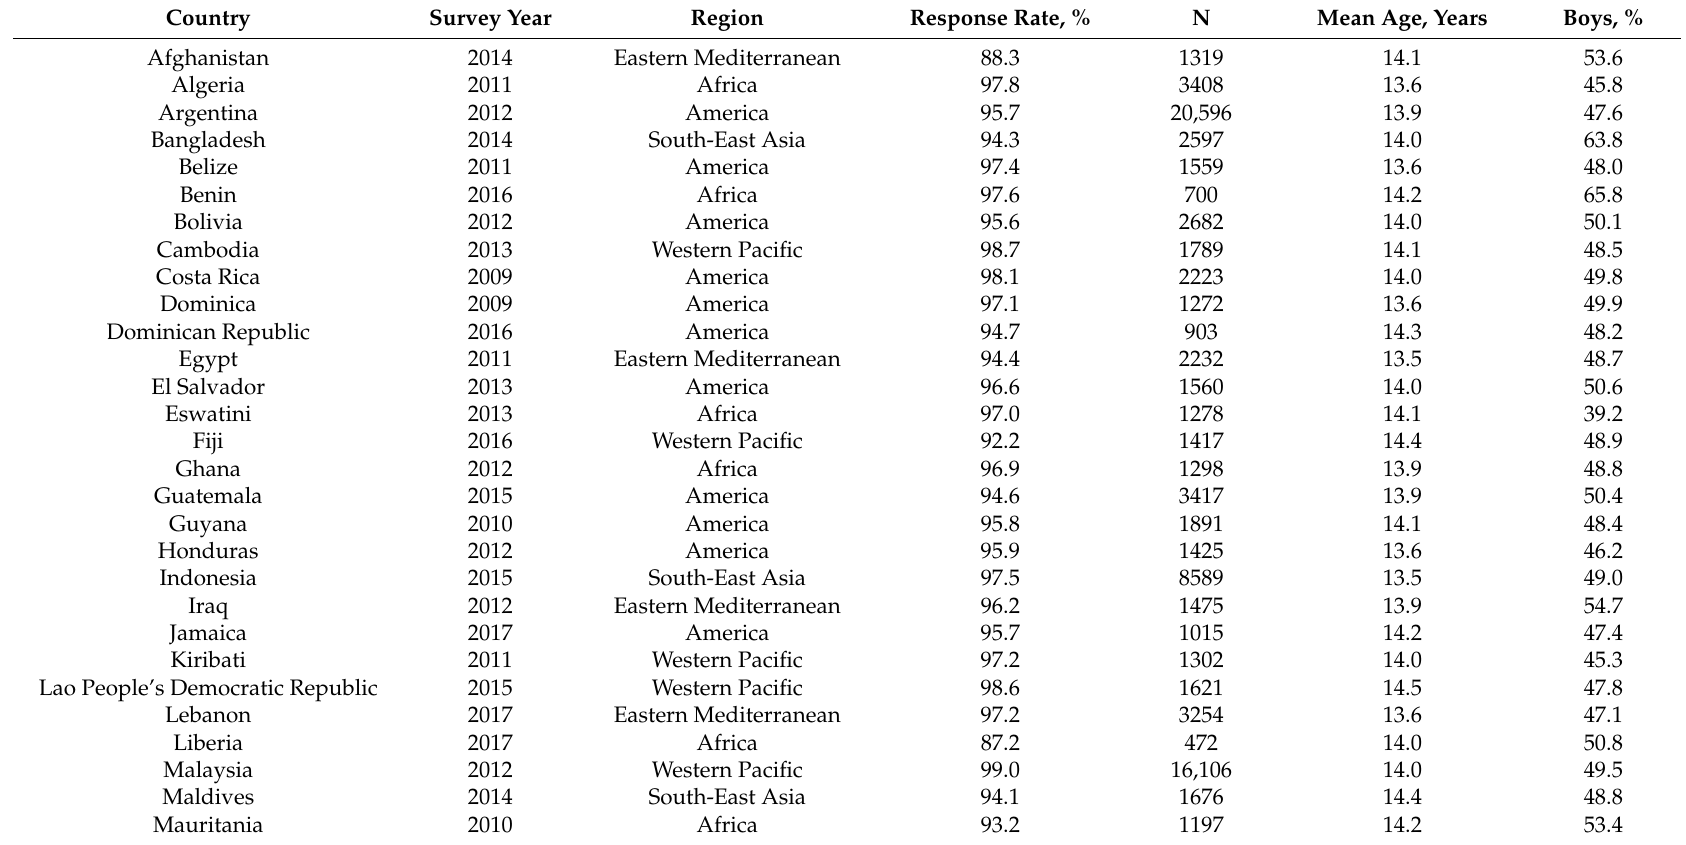
Table 1. Characteristics of all participants aged 12–15 years across